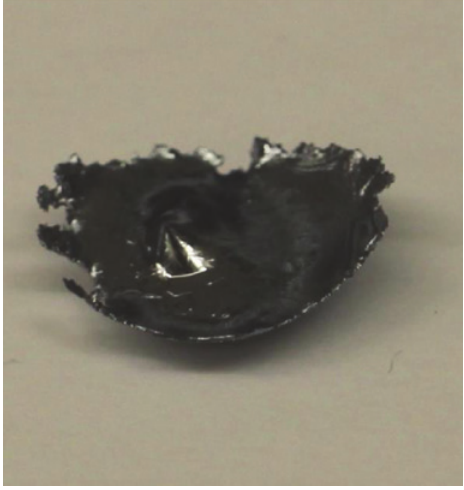
Fig. 7: Quenched silicon sample